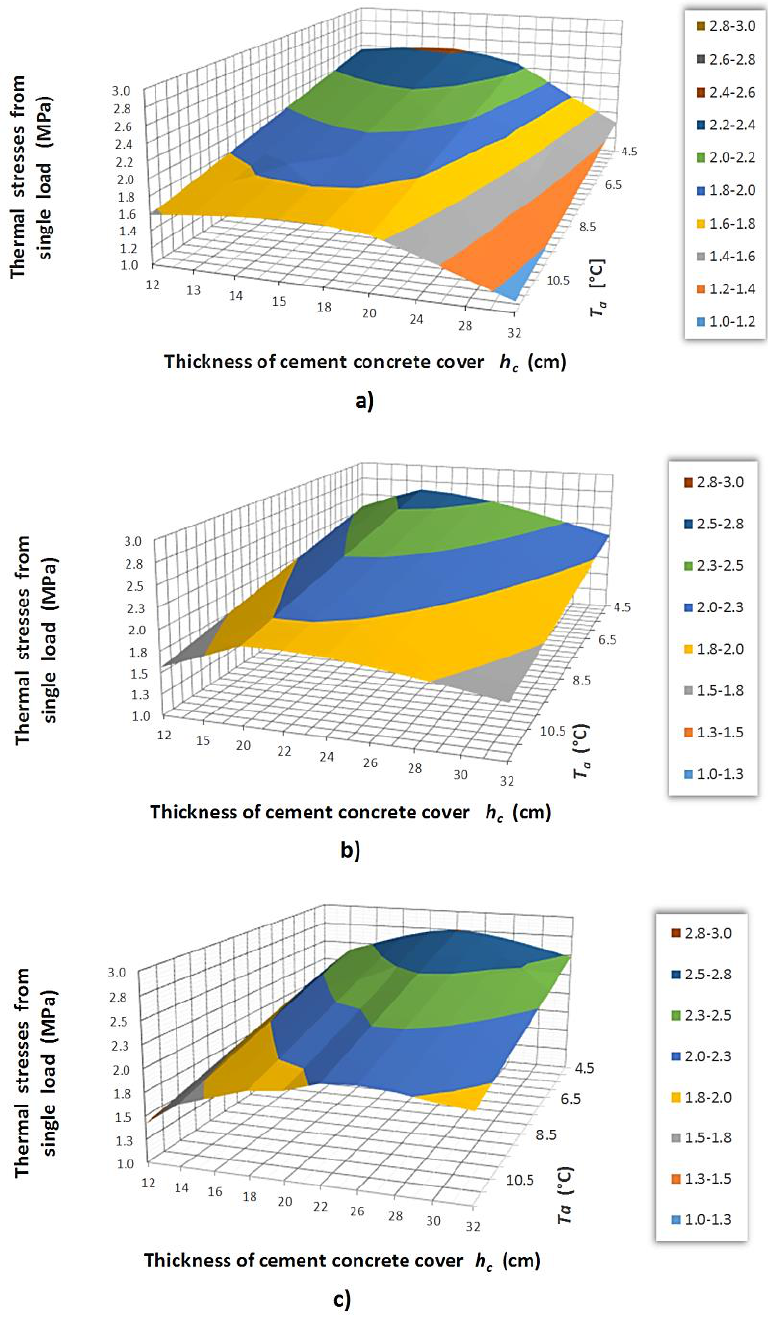
Figure 12. Dependences of thermal stresses from the single load of 115 kN design for thicknesses from 12 to 32 cm of cement concrete cover h c on the annual average air temperature T a from 4.5 to 11.5 ◦ C for the modulus of subgrade reaction k: ( a ) 100 MN · m − 3 , ( b ) 200 MN · m − 3 , and ( c ) 300 MN · m − 3